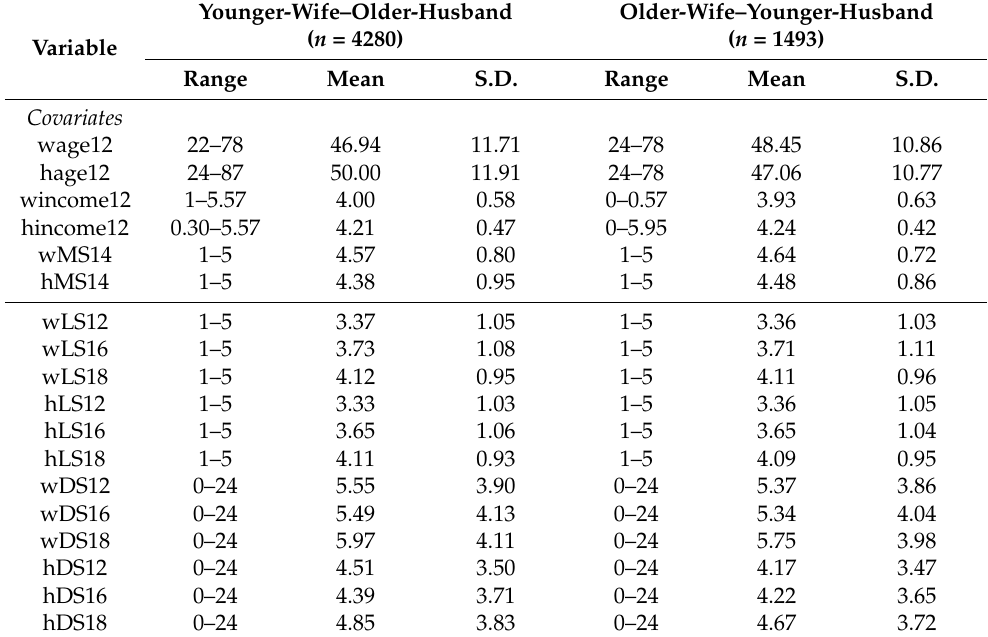
Table 1. Demographic characteristics and descriptive